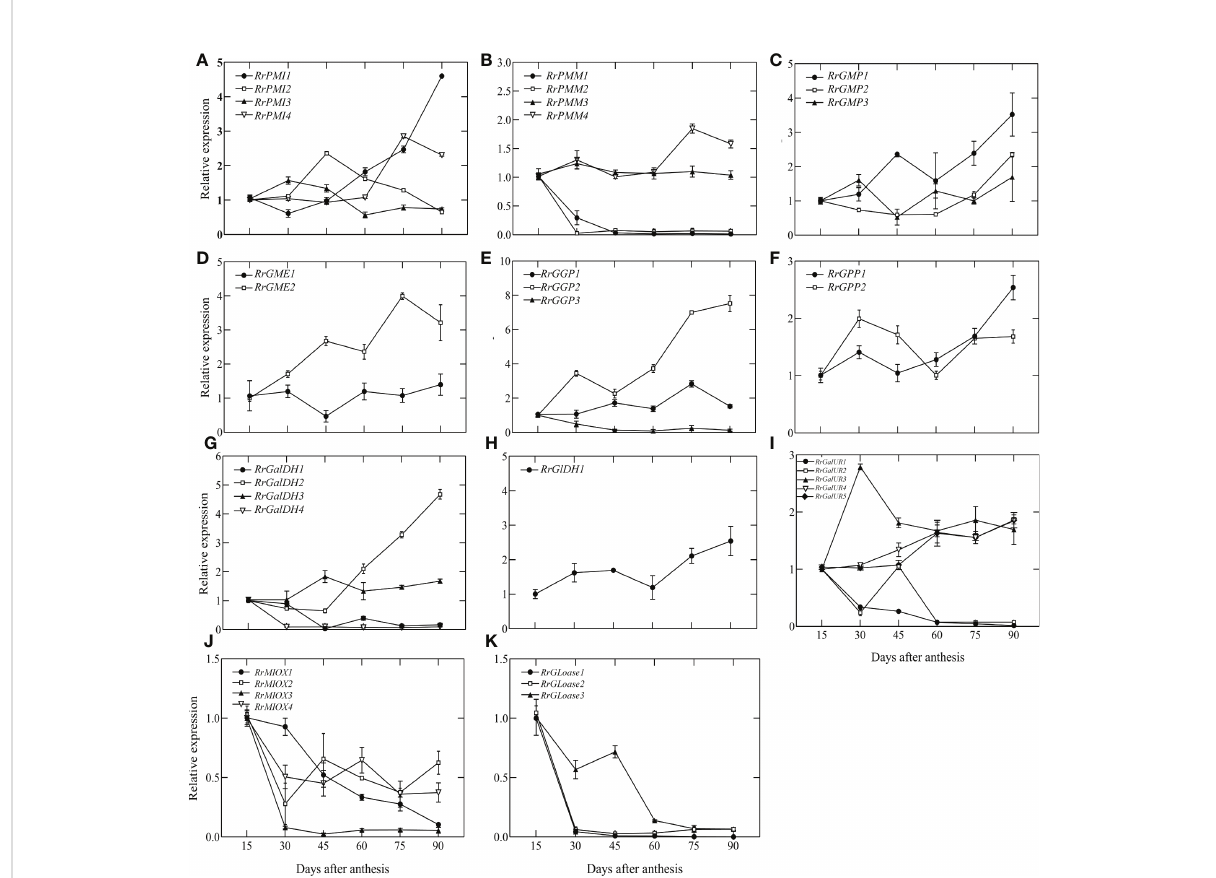
FIGURE 3 The relative expression of genes involved in AsA biosynthesis during fruit development. L-galactose pathway: (A-H) D-galacturonic acid pathway: (I, H) ; Myo-inositol pathway: (J, K) ; L-gulose pathway: (D, K) . For each sample, transcript levels were normalized to UBQ ; expression over time was determined relative to a designation of ‘ 1 ’ at 15 DAA. Values are means of at least 3 replicates ±